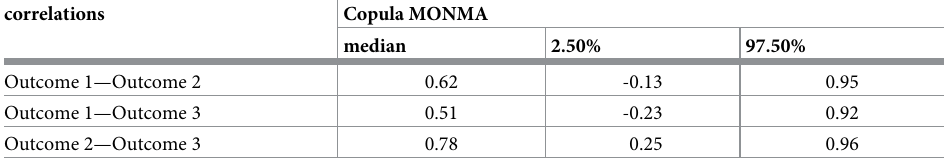
Table 8. Alcohol dependence: Within outcomes